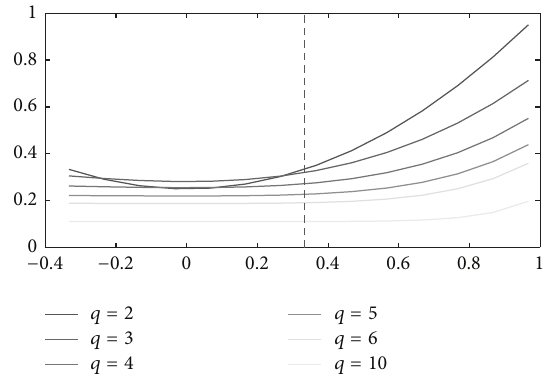
Figure 1: The 𝑞 -information 𝐼 𝑇 𝑞 of the Werner state (17) of the qudit with spin 𝑗 = 3/2 against the parameter 𝑝 for different values of the deformation parameter 𝑞